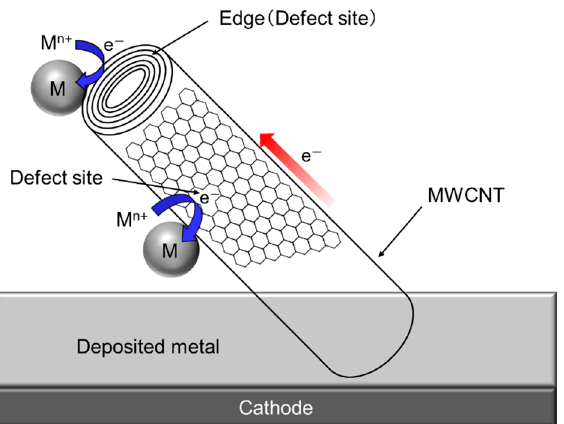
Figure 7. Schematic of unique phenomenon of composite plating using MWCNTs as inert particles. (Figure 7 is adapted from reference [34]). Using this unique phenomena, powder Cu/MWCNT composites could be obtained